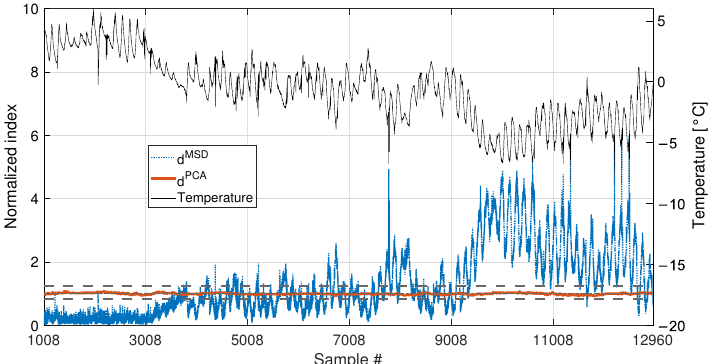
Figure 18. Comparison between d MSD (blue dotted line) and d PCA (red solid line), with b = 1008, in case of a real temperature trend (black thin